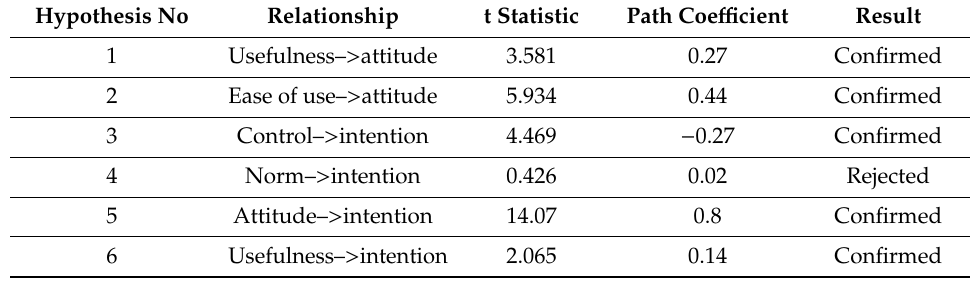
Table 5. The values of t statistic and path coefficient.